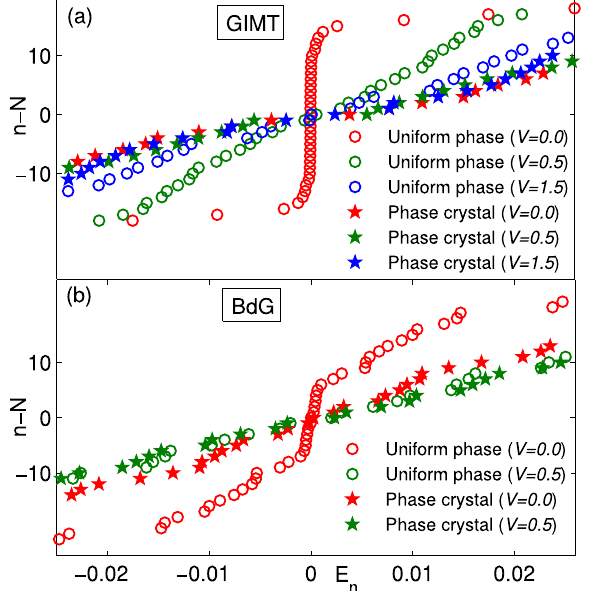
Fig. 5 Distribution of low-energy eigenvalues for disordered sample. Eigenvalues E n within GIMT ( a ) and BdG ( b ) at the same temperature as in Fig. 4 ( T = 0.32 T * < T s ), with stars (circles) for the phase crystal (uniform phase) state at different disorder strengths V . The phase crystal state within GIMT in ( a ) is stable for all V , while the eigenvalues for the phase crystal and uniform phase states almost overlap within BdG in ( b ), corroborating the fact that the phase crystal does not survive disorder when strong correlations are ignored.